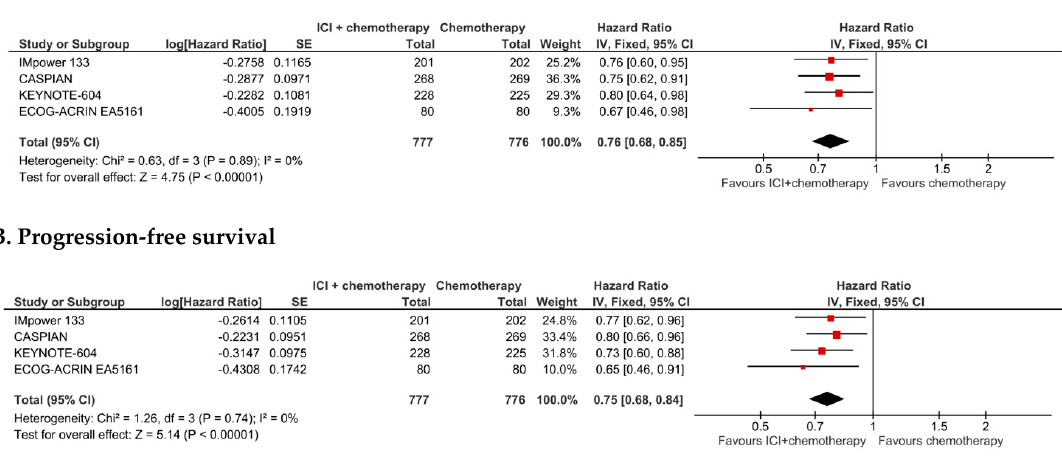
Figure 1. Overall survival ( A ) and progression-free survival ( B ) plots for the four clinical trials included in the meta-analysis, in the intention-to-treat populations. IV: Inverse variance; 95% CI: 95% confidence interval.